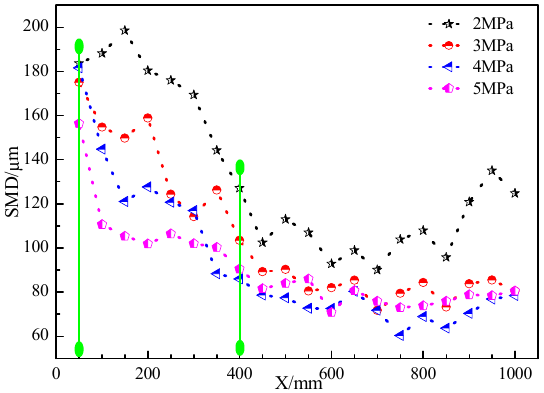
Figure 14. SMD distribution along the central axis at different pressures.